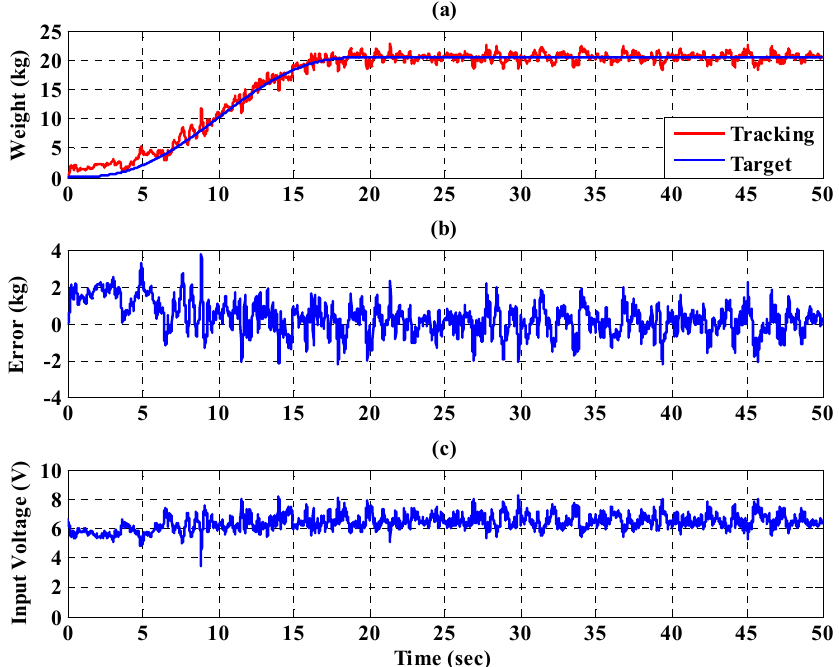
Figure 24. Experimental results for the PBWSS with a dynamic bodyweight unloading force of 30% (20.4 kg) in 50 s. ( a ) Tracking trajectory; ( b ) tracking error; ( c ) control